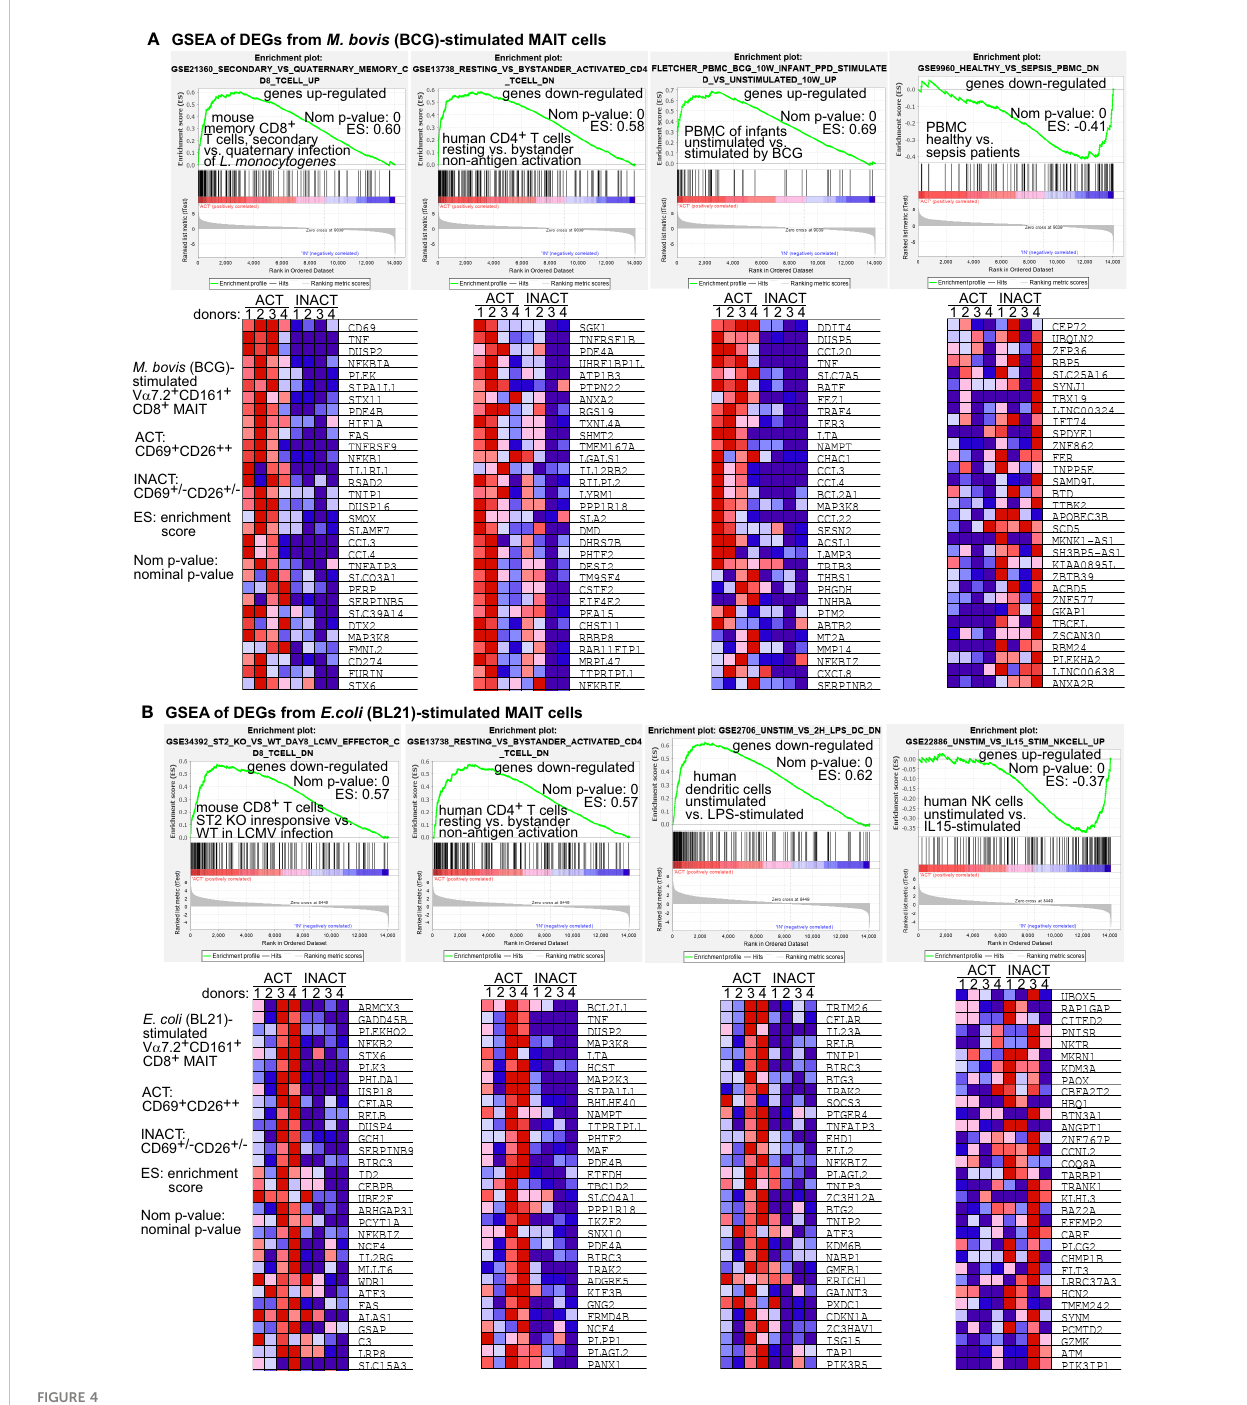
FIGURE 4 Gene set enrichment analyses (GSEA) support that BCG-stimulated MAIT cell transcriptomes are comparable with CD8 + T cells in intracellular microbial infections. BCG-stimulated DEG genes of MAIT cells were analyzed using the GSEA program to identify comparable gene sets with similarly enriched genes from different cell types under various stimulation conditions. The representative gene sets with T cells or other immune cells were selected from the top 20 out of over 4000 enriched gene sets. The representative core-enriched MAIT cell genes shown in heatmaps were selected based on the top running enrichment scores (ES) of the enriched genes (A) . E. coli -stimulated DEG genes of MAIT cells were similarly analyzed using the GSEA program and shown with representative enrichment plots and enriched genes (B)